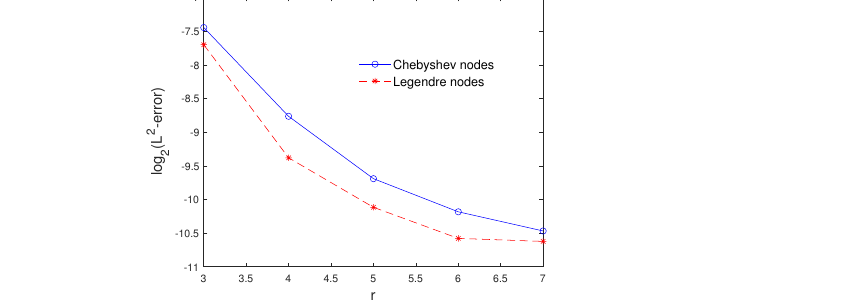
Figure 2. The L 2 –errors for µ = 1 at the Chebyshev and Legendre nodes for Example 2.